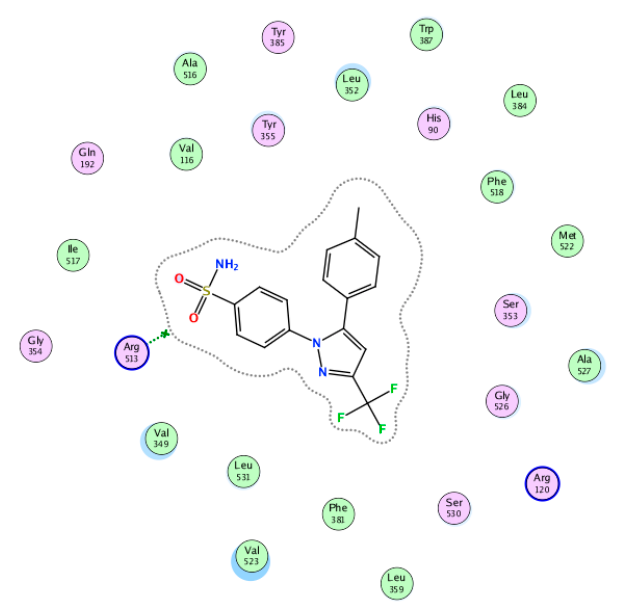
Figure 3. Interaction of celecoxib with COX-2 protein.